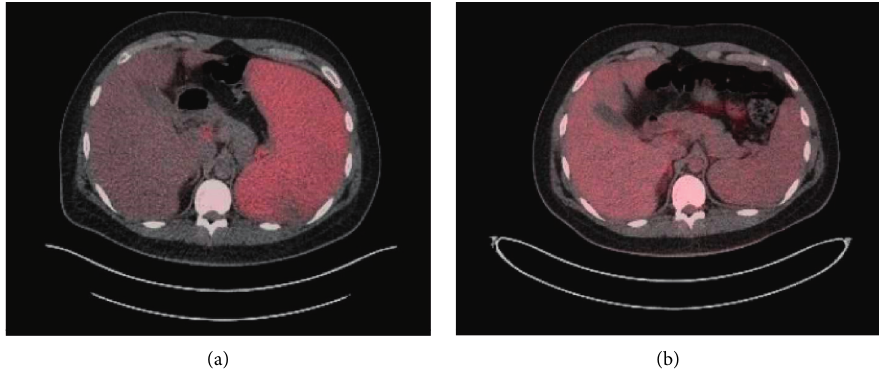
Figure 1: PET/CTcomparison after 4 weekly dose of rituximab. Pretreatment PET/CT (a) showing FDG-avid splenomegaly. PET/CTafter 4 weekly doses of rituximab 375mg/m 2 (b), demonstrating a complete response.